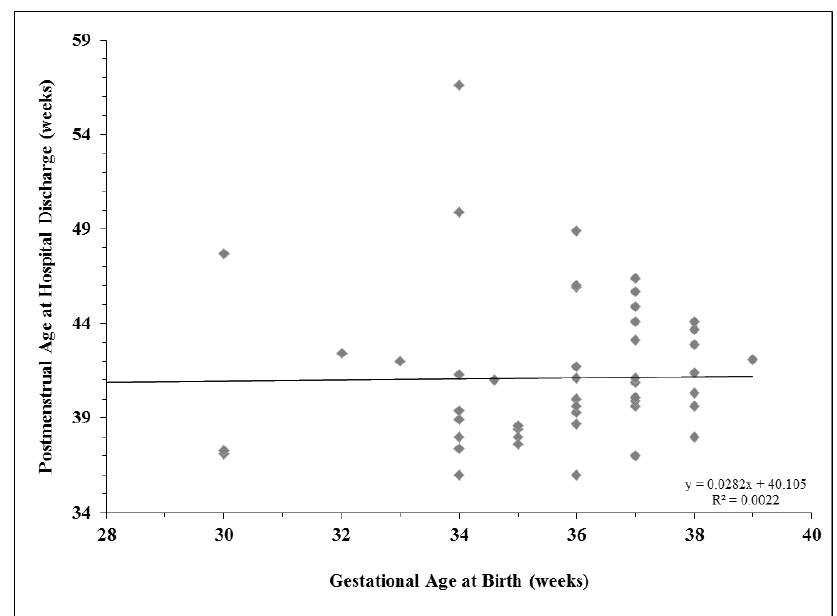
Figure 2: Relationship between gestational age at birth and postmenstrual age at initial hospital discharge for infants with